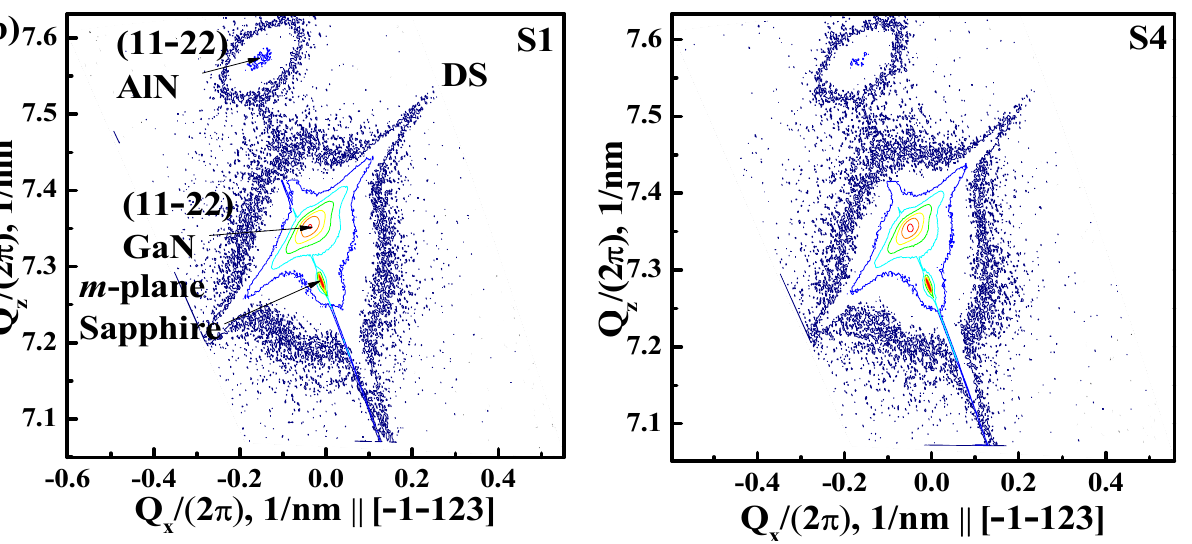
Figure 4. X-ray reciprocal space maps (RSM) of (11 2(cid:3364) 2) GaN on m -plane sapphire for sample S1 and S4 along directions ( a ) [1 1(cid:3364) 00] and ( b ) [ 11(cid:3364)(cid:3364)(cid:3364)(cid:3364) 23]. Room temperature Raman spectroscopy using z(xx) 𝑧̅ scattering configuration was used to examine the effect of the flux rate on the compressive stress of all samples. As shown in Figure 5a, the peaks for (10 1(cid:3364) 0) sapphire substrate are found at 378, 416, 741 cm −1 whereas the peaks of A 1 , E 1 and E 2 are responsible for semi-polar GaN epitaxial layer [40]. It is known that the E 2 mode is sensitive to the in-plane stress of the GaN layer; hence, any shifting to a lower or higher value of 568 cm −1 (standard stress-free GaN E 2 peak value) indicates a tensile or compressive strain. However, none of the samples deviate from the critical point; elucidating the flux rate did not have a significant effect on the GaN in-plane stress. The FWHM of the E 2 peak can also be utilized to exhibit the crystal quality of the GaN layer [41]. Figure 5b shows that the FWHM of GaN E 2 peaks decreased from S1 to S4, suggesting that the increase in the E 2 peaks as flux rate decreases are in agreement with the HR-XRD on-axis XRC measurements. We then carried out AFM measurement to probe the effect of the flux rate on the surface morphology.